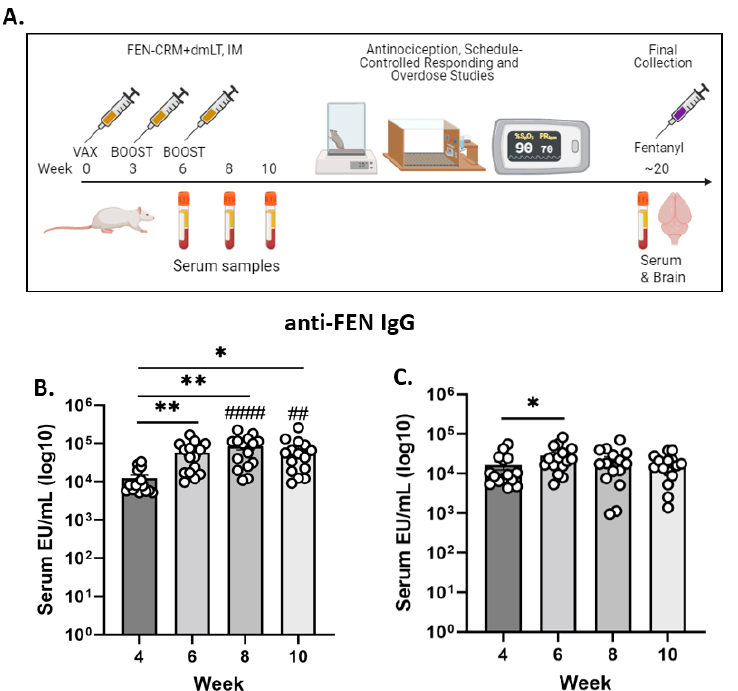
Figure 1. Experimental design sequence and immunogenicity of the FEN-CRM+dmLT vaccine formulation. Timeline and sequence of the experiments are presented in ( A ) and was created with BioRender.com. Rats (N = 15) were vaccinated at weeks 0, 3 and 6 and blood samples obtained at 6, 8, 10 and blood and brain samples taken at 20 weeks. IgG antibody levels were determined using ELISA with FEN-BSA as the coating antigen. Anti-FEN IgG antibody levels over weeks in male Sprague Dawley rats are presented in ( B ). Anti-FEN IgG antibody levels over weeks in female Sprague Dawley rats are shown in panel ( C ). Data are presented as serum EU (ELISA Units)/mL (log 10, mean ± SEM). * p > 0.05, ** p < 0.01; Male vs. Female ## p < 0.01, #### p < 0.0001.